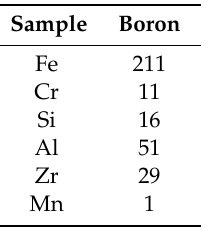
Table 2. The certified impurities in boron powder (ppm mass).